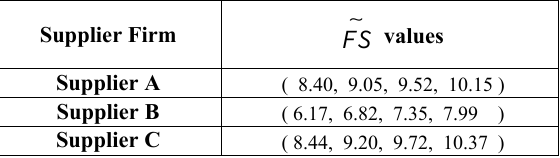
Table 5. The ranking of alternatives.